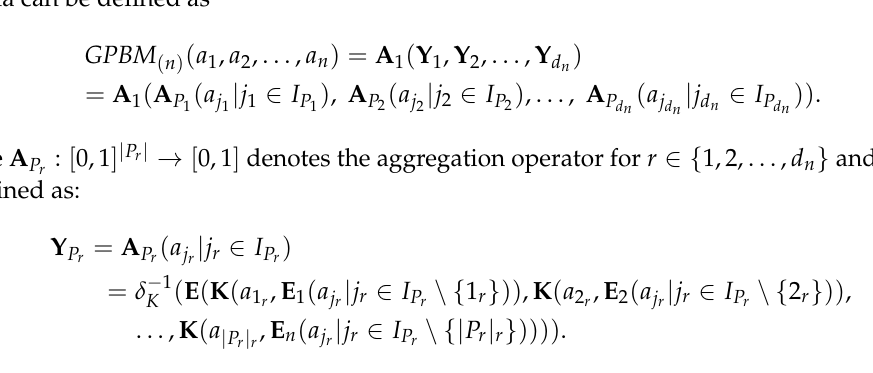
Figure 2. Aggregation process of hierarchical data